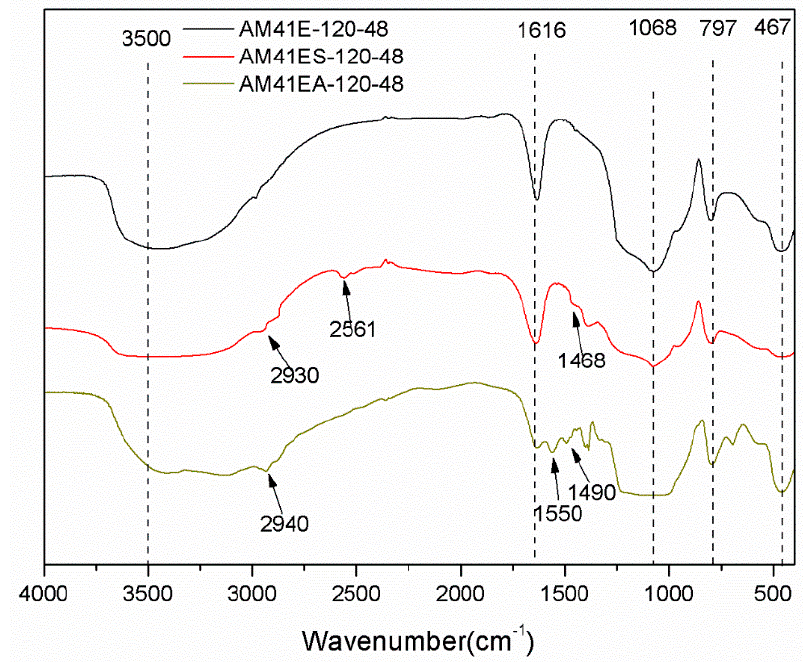
Figure 8. FTIR patterns for AM41E-120-48, AM41ES-120-48, and AM41EA-120-48. Figure 9a,b show the 29 Si NMR spectra of Al-MCM-41 crystallized at different tem- peratures and times. Each sample had two noticeable resonances at − 102 (or − 101) and − 112 (or − 111) ppm, which were attributed to the siloxane binding surroundings without hydroxyl groups [Si(OSi) 4 (Q 4 )] and with isolated silanes [Si(OSi) 3 (OH) (Q 3 )], respec- tively. We obtained the areas under Q 4 and Q 3 by deconvolution, as shown in Table 6. With increasing crystallization temperature and aging time, the value of Q 4 /Q 3 increased. This illustrates that a higher temperature and longer time promoted the polymerization of silanol, forming more Q 4 units at the cost of Q 3 , which concurs with findings from Cheng et al. [18]. When using calcination to remove the template, as shown in Figure 9c, the value of Q 4 /Q 3 increased sharply due to high-temperature dehydration. Upon ligand grafting, we also observed two additional resonances at ca. − 60 and − 70 ppm, as shown in Figure 9d. They were attributed to SiR(OSi) 3 (T 3 ) and SiR(OSi) 2 (OH) (T 2 ), indicating the successful bonding of organic ligands to the silica host